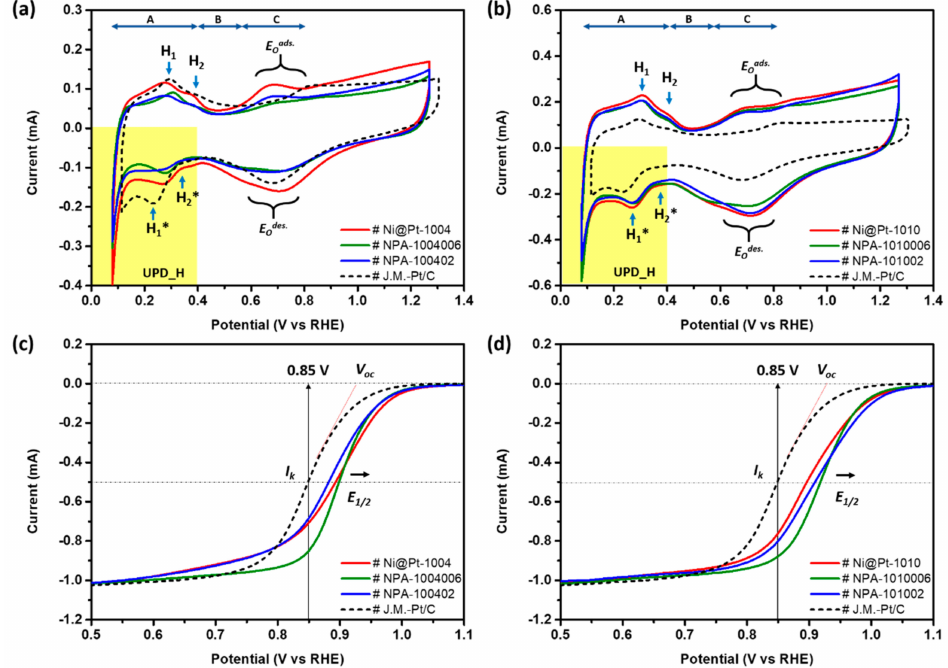
Figure 4. Electrochemical analysis of experimental nanocatalysts (NCs). ( a , b ) CV and ( c , d ) LSV curves of experimental NCs compared to a commercial Johnson Matthey-Pt / C NC. Potential sweeping curves were measured at a rotation speed of the electrode of 1600